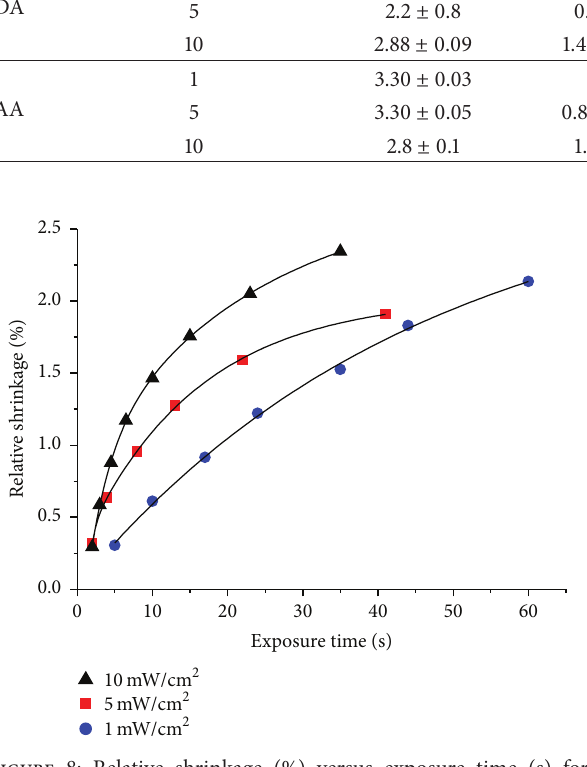
Figure 8: Relative shrinkage (%) versus exposure time (s) for gratingsrecordedin120 𝜇 mDAphotopolymerlayerswithrecording intensities of 1, 5, and 10mW/cm 2 , fitted with a double exponential